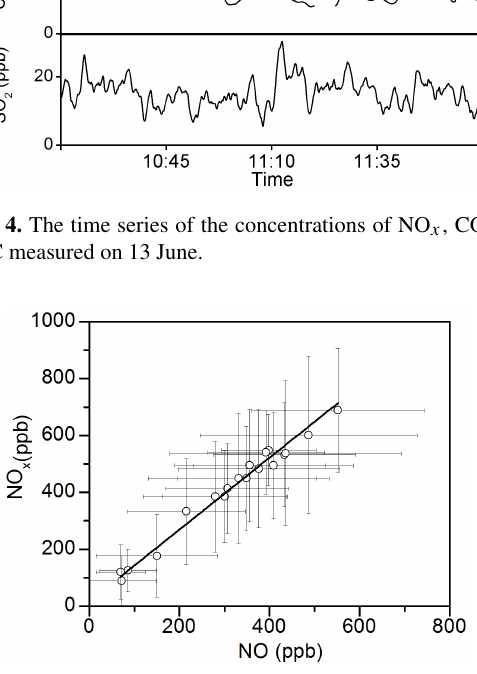
Figure 5. The regression curve of the means of concentrations of NO x and NO and the error bars in all 19